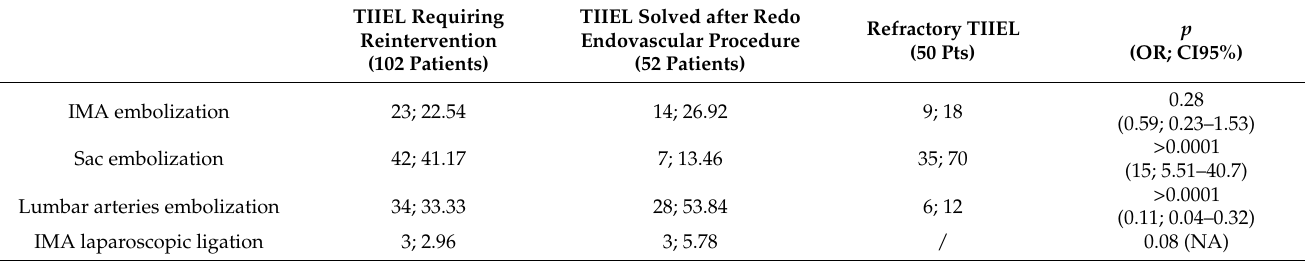
Table 5. Redo endovascular procedures performed to treat persistent TIIEL in present